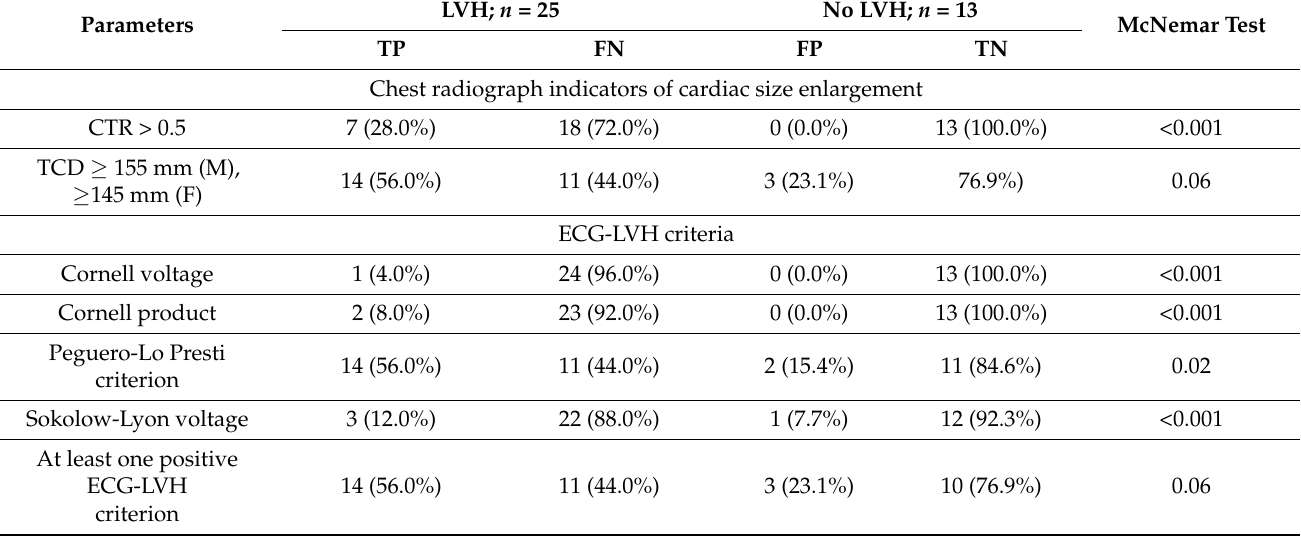
Table 3. Radiographic and electrocardiographic criteria in the screening for left ventricular hypertro- phy in patients with and without left ventricular hypertrophy based on left ventricular mass indexed by body surface